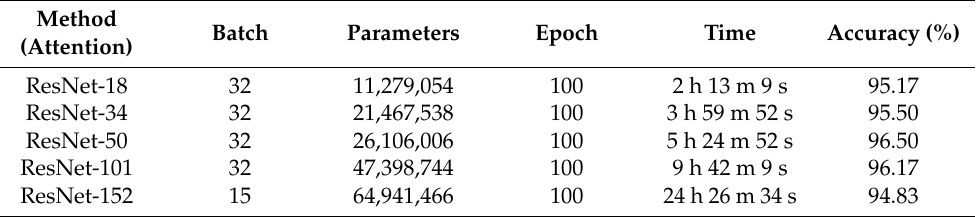
Table 2. Parameters and results of the training model with attention